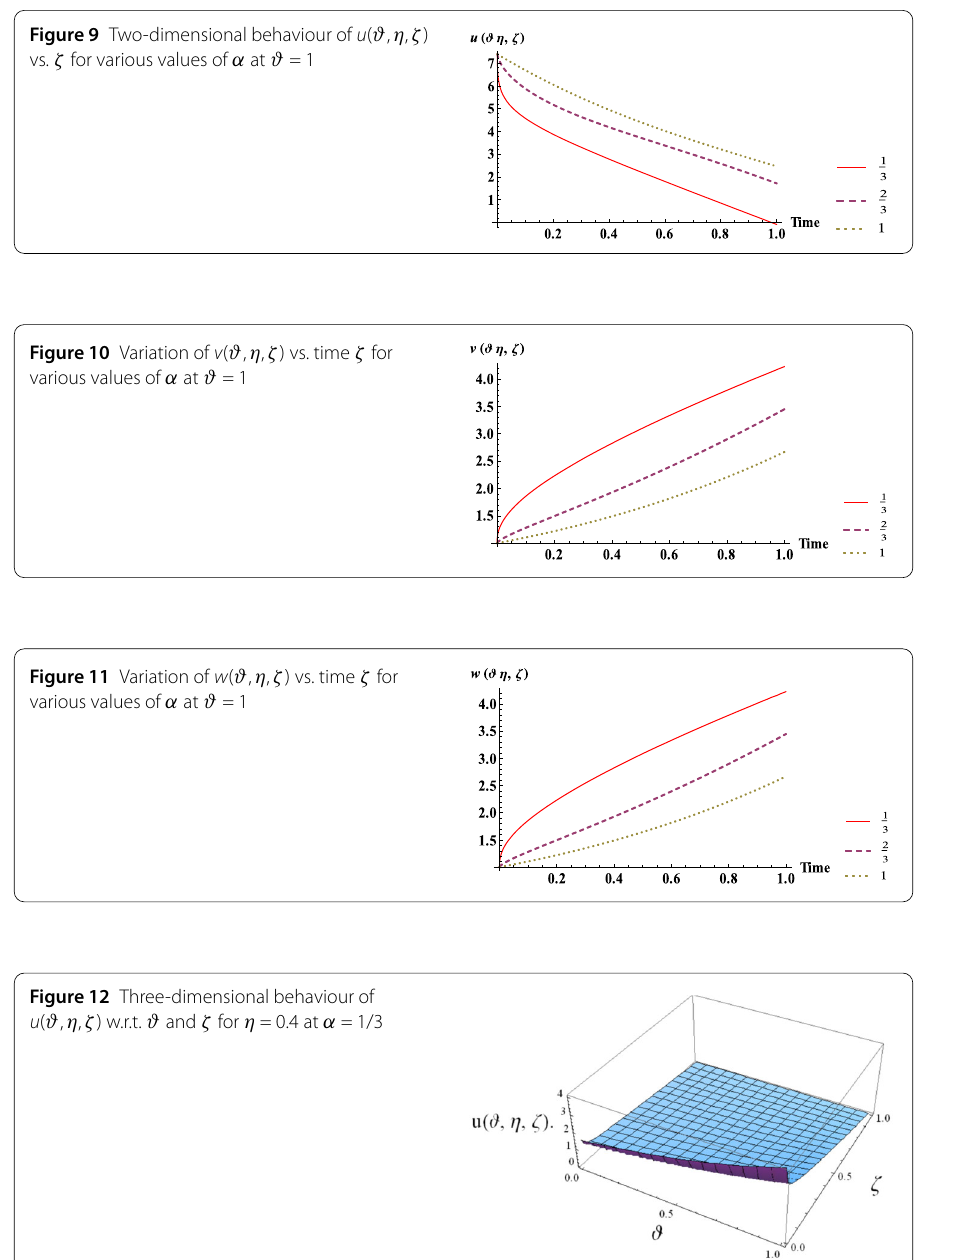
Figure 9 Two-dimensional behaviour of u ( ϑ , η , ζ ) vs. ζ for various values of α at ϑ = 1